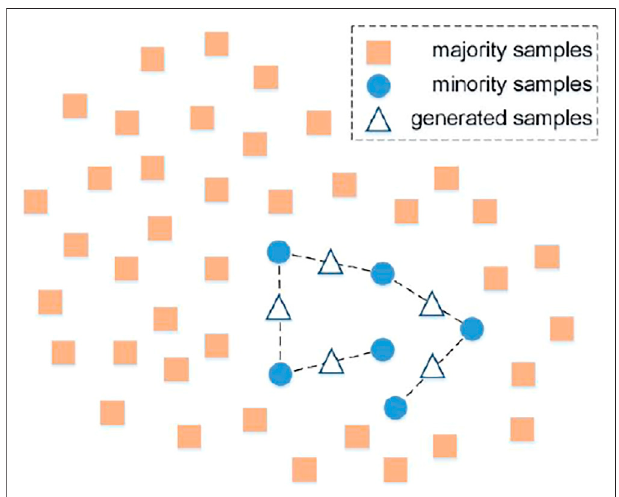
FIGURE 1 | Schematic diagram of the SMOTE